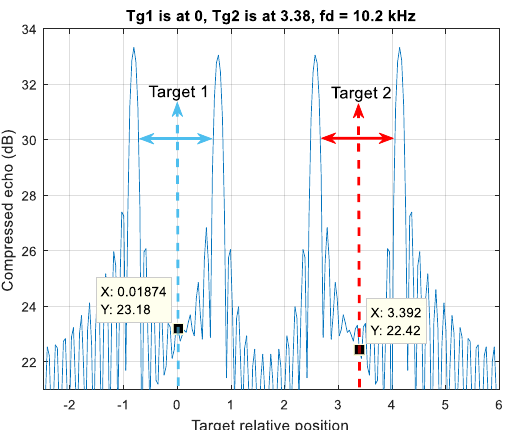
Figure 5. Case 1, an up-down chirp LFM waveform resolves four detection peaks by two moving targets. The detection pair of each target has no crossover. Sensors 2020 , 20 , x FOR PEER REVIEW